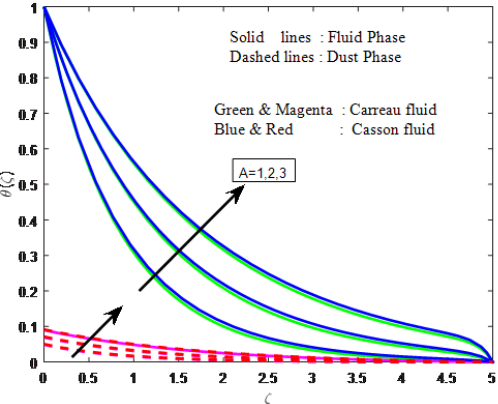
Fig. 12: Impact of K on temperature profiles. Table 1: Validation of the local Nusselt number for the case of